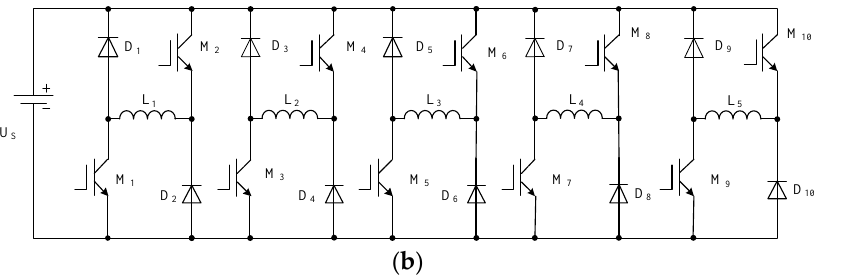
Figure 2. SRM circuit topology. ( a ) One phase (the other four phases are similar); ( b ) Drive circuit.